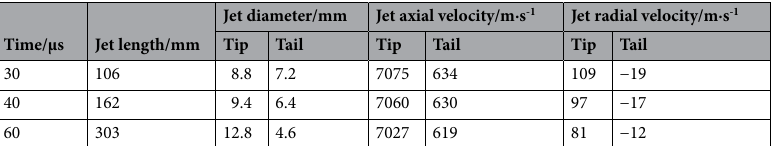
Table 3. Simulation results of the 2D/Euler